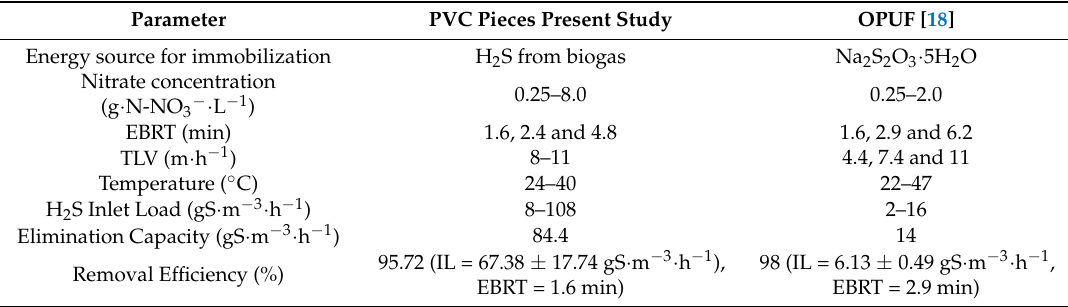
Table 3. Comparison of results from different parameters in a biotrickling filter packed with PVC pieces and